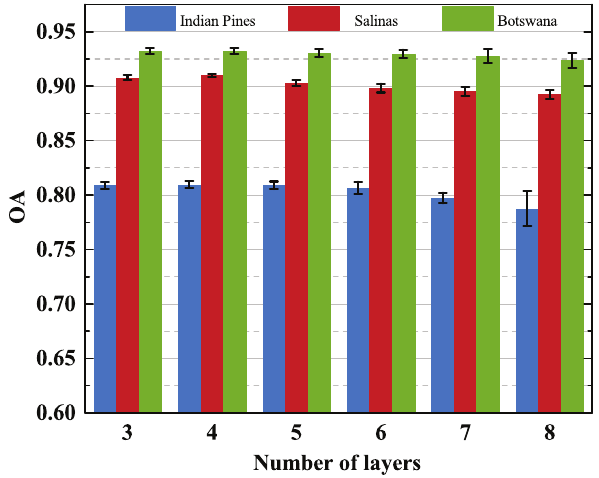
Figure 10. Classification accuracies with numbers of layers on MMDBN.